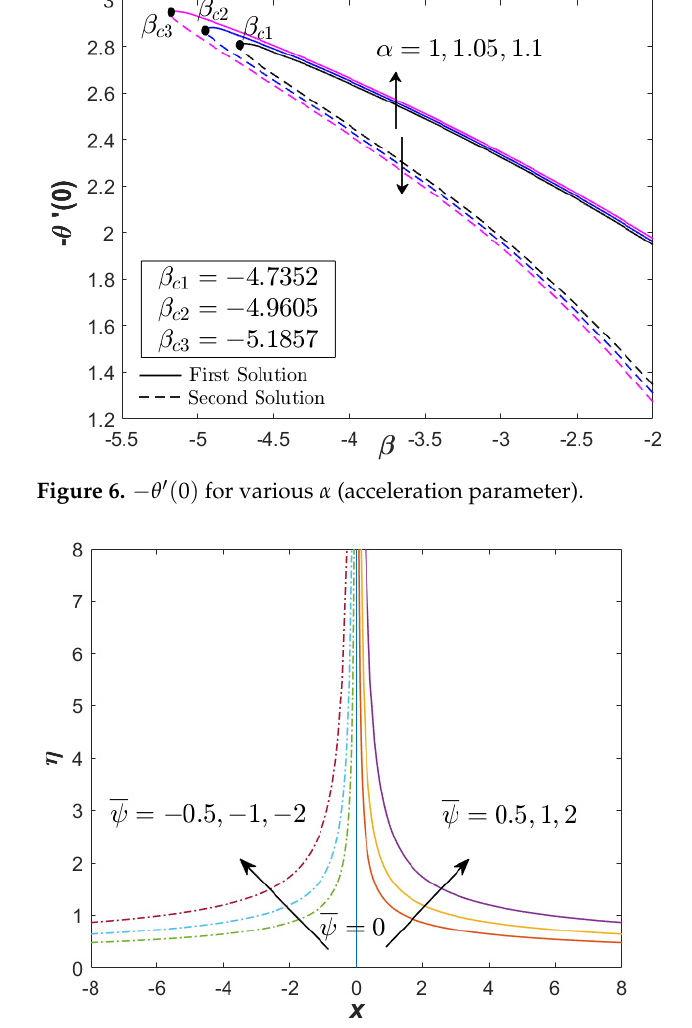
Figure 7. Streamline for the first (real) solution when α = 1.1, β = − 3 (unsteady decelerating flow), M = 0.25, Q = 0.1, and φ hf f =